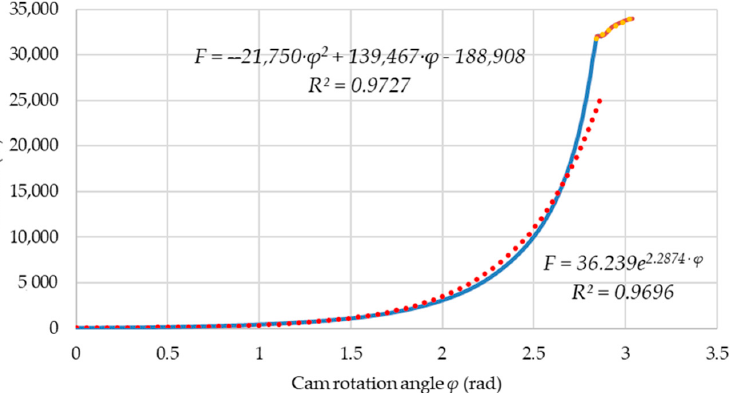
Figure 17. Regression curves for the two highlighted sections of the characteristic of variance of the compaction force F obtained on the basis of the experimental results as a function of the rotation angle of cam 7 (Figure 13).